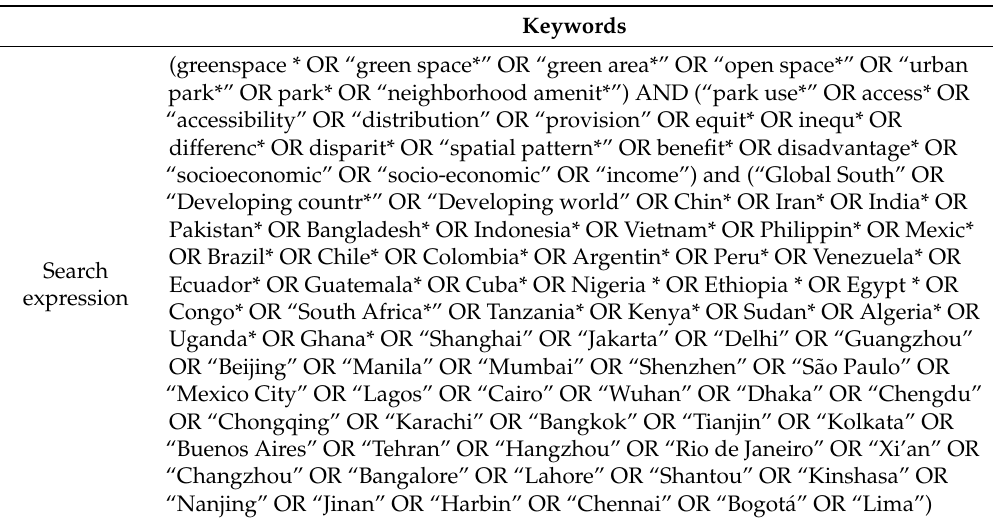
Table A1. Search expressions for Scopus and Web of